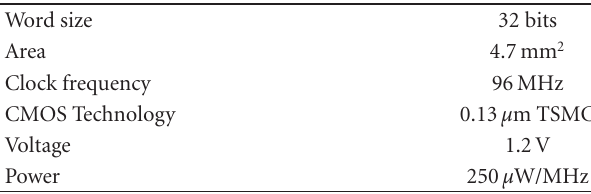
Table 4: ARM9 reference architecture.